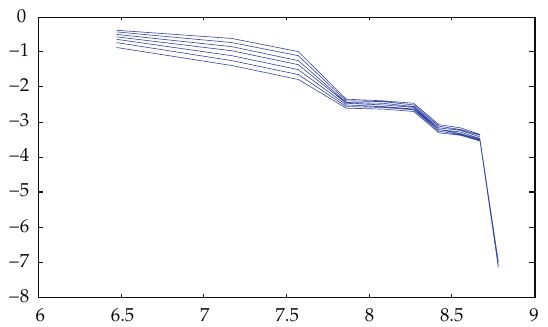
Figure 11: The fitting chart of rehabilitation group for BI baseline fractal m (cid:8)